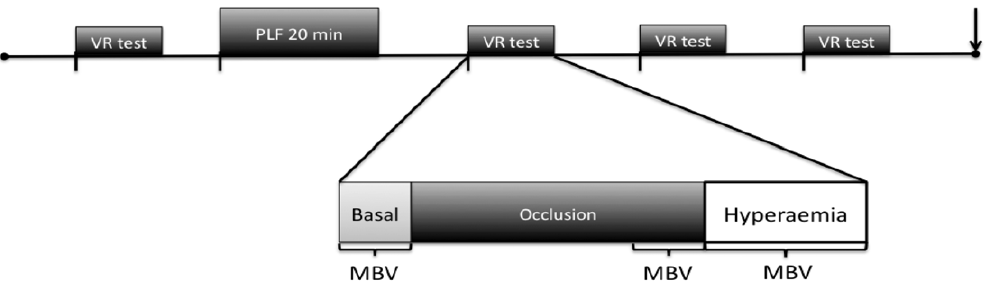
Figure 1. Schematic representation of a testing session timeline. Participants arrived at the laboratory and rested supine for 20 minutes prior to a brachial artery vascular function assessment (VF test). A ten-minute recovery period was immediately followed by prolonged low flow (PLF 20 min) and subsequent VF tests were completed at 15, 30 and 45 minutes into recovery. A venous blood sample was obtained at 120minutes ( Q ). The VF test mean blood velocity (MBV) measurements are highlighted in the expansion. Basal MBV was measured prior to cuff inflation; occlusive MBV 30s prior to cuff deflation; and hyperaemic MBV was measured continuously for 90s after cuff release as illustrated.